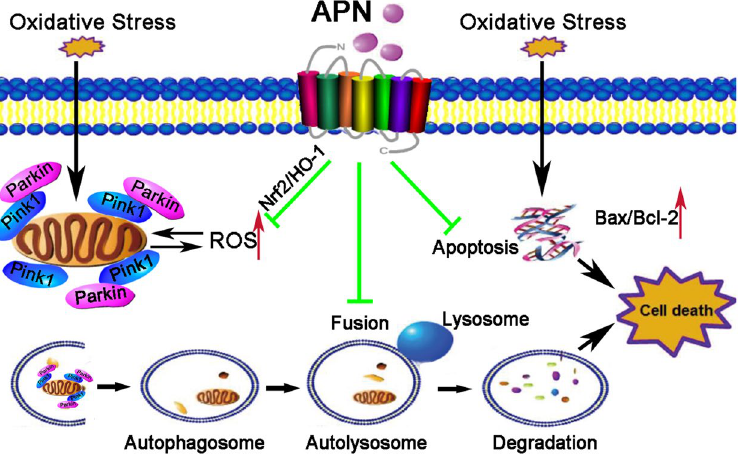
Figure 7. Proposed model of action of APN on oxidative stress. H 2 O 2 administration to C2C12 cells causes reductions in mitochondrial membrane potential, ROS production and apoptosis. High levels of ROS and depolarized mitochondria induced mitophagy. APN pretreatment suppressed the over-production of ROS by activating the Nrf2/HO-1 pathway, protecting mitochondria, inhibiting Parkin E3 ubiquitin ligase and modulating mitophagy by partially blocking the colocalization of mitochondria with autophagosomes/ lysosomes. In addition, APN downregulates the transcript levels of both Bax and Bax/Bcl-2 protein induced by oxidative